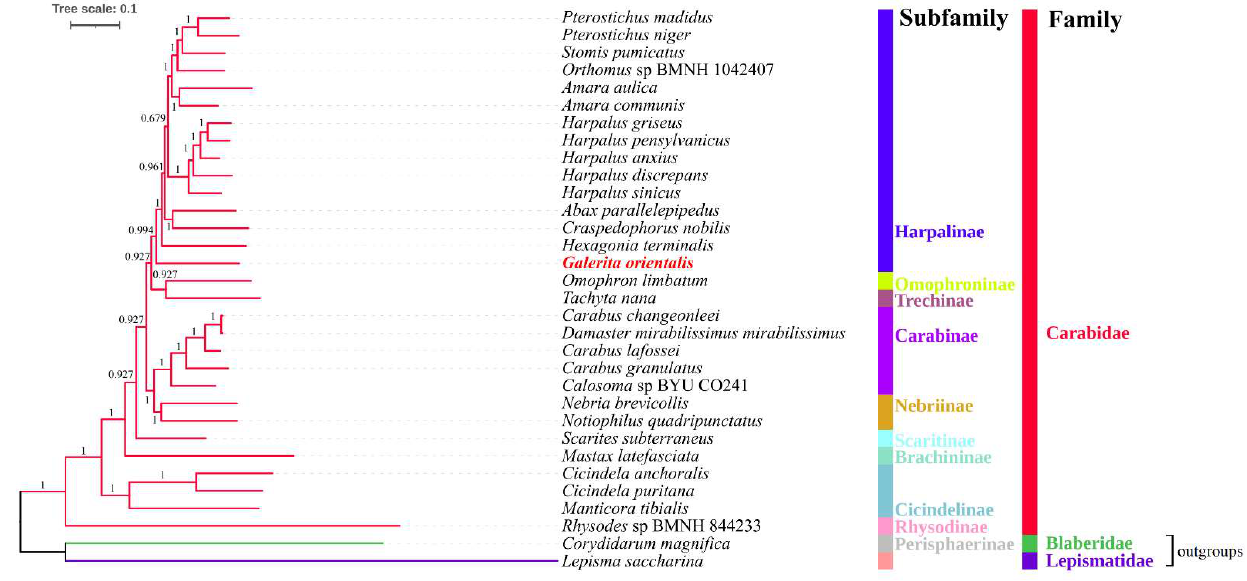
Figure 6. Bayesian-inferred phylogenetic tree of the nucleotide sequences of 13 protein-coding genes (PCGs) of 32 mitogenomes using MrBayes under the GTR + F + I + G4 model. Bayesian inference (BI) poster probability values are indicated near the nodes. The newly determined Galerita orientalis is shown in red. The branches of the family Carabidae are shown in red. L . saccharina and Co . magnifica are outgroups, and the corresponding branches are shown in green or purple.